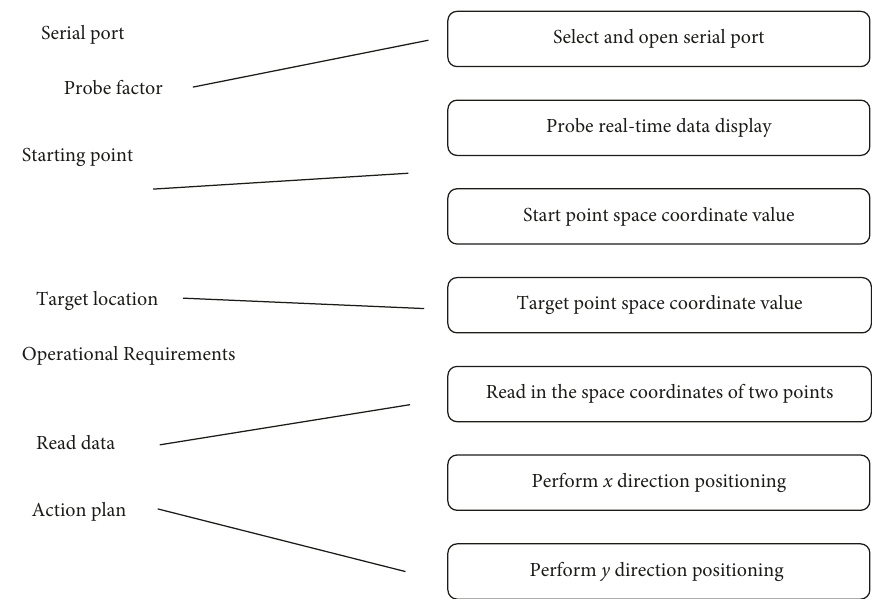
Figure 3: Software calibration page control.